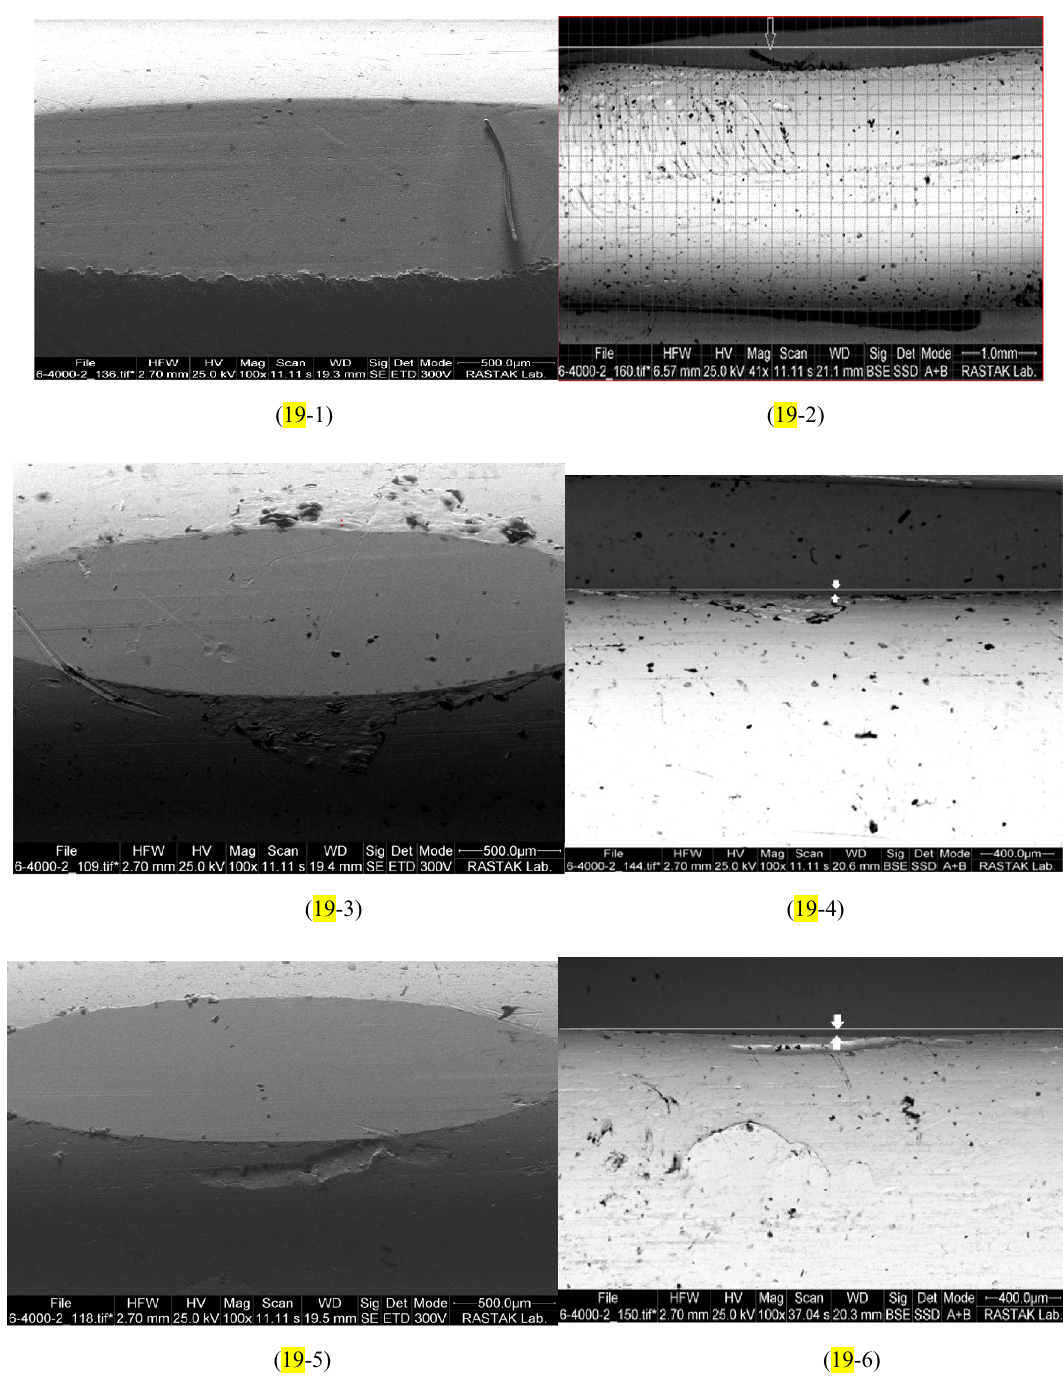
Figure 19. The wear depth of copper pins in the presence of: ( 19-1 , 19-2 ) pure fluid 42 , ( 19-3 , 19-4 ) nanofluid with 0.05 wt.% of MWCNTs, ( 19-5 , 19-6 ) nanofluid with 0.1 wt.% of MWCNTs, ( 19-7 , 19-8 ) nanofluid with 0.2 wt.% of MWCNTs, ( 19-9 , 19-10 ) nanofluid with 0.3 wt.% of MWCNTs, ( 19-11 , 19-12 ) nanofluid with 0.4 wt.% of